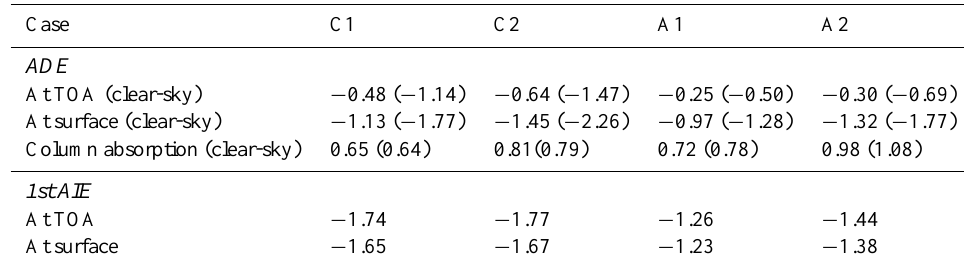
Table 9. Aerosol direct and 1st indirect forcing (Wm − 2